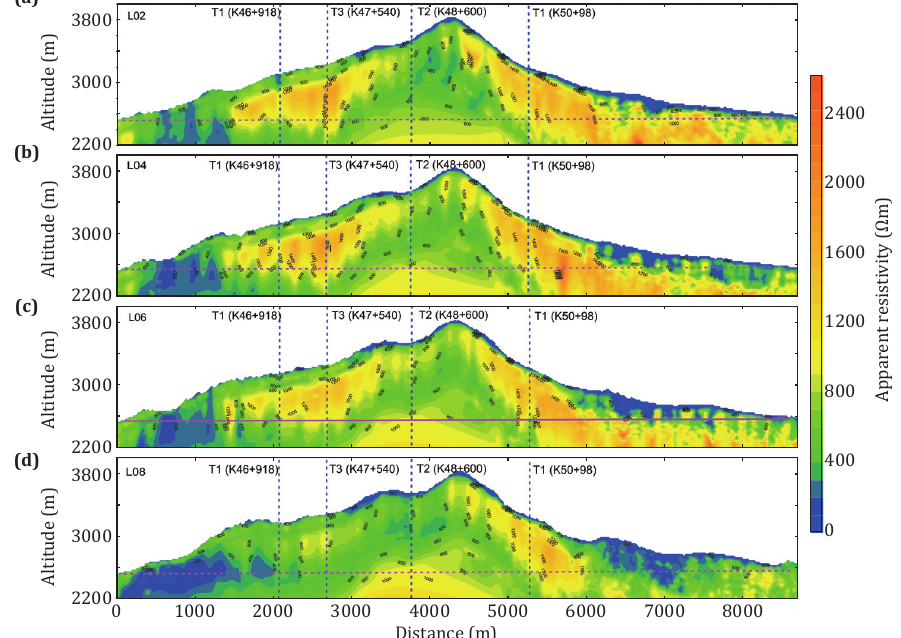
Figure 7. Apparent resistivity result of the survey line. ( a ) L2 line. ( b ) L4 line. ( c ) L6 line. ( d ) L8 line.